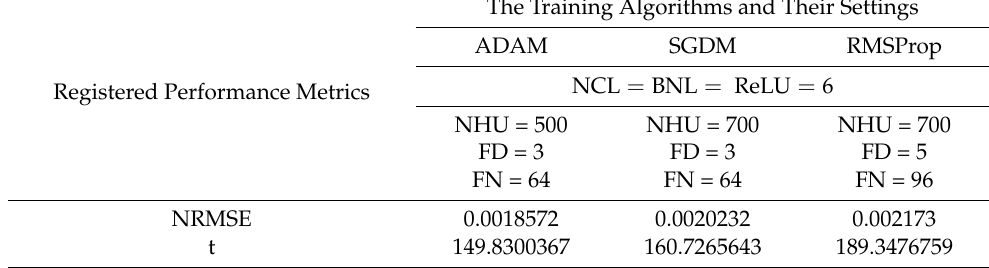
Table 3. A synthesis of the best results registered for the three training algorithms (t is measured in seconds).